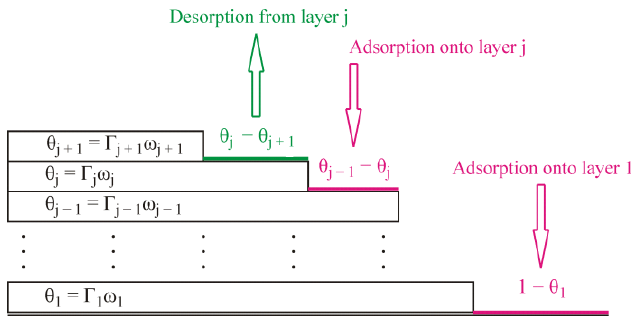
Figure 1. Schematic of adsorption in a multilayer system. The horizontal bars correspond to the fraction of total surface area covered by molecules in the j-th layer, while the arrows correspond to the adsorption onto and the desorption from a layer. Note that the total surface coverage corresponds to θ = 1.